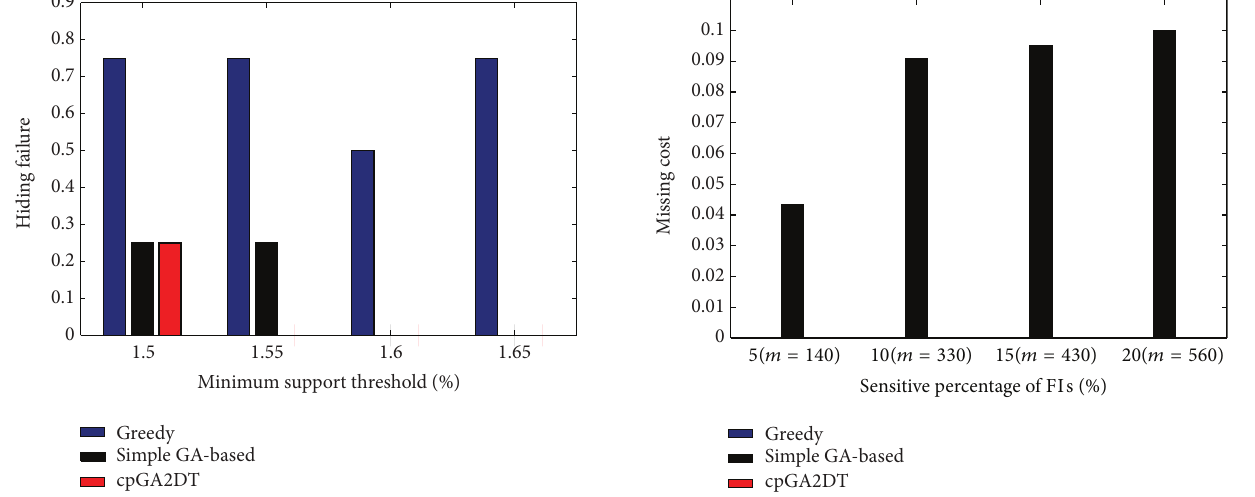
Figure 20: Comparisons of missing cost at various sensitivity percentages of frequent itemsets for BMSWebview-2